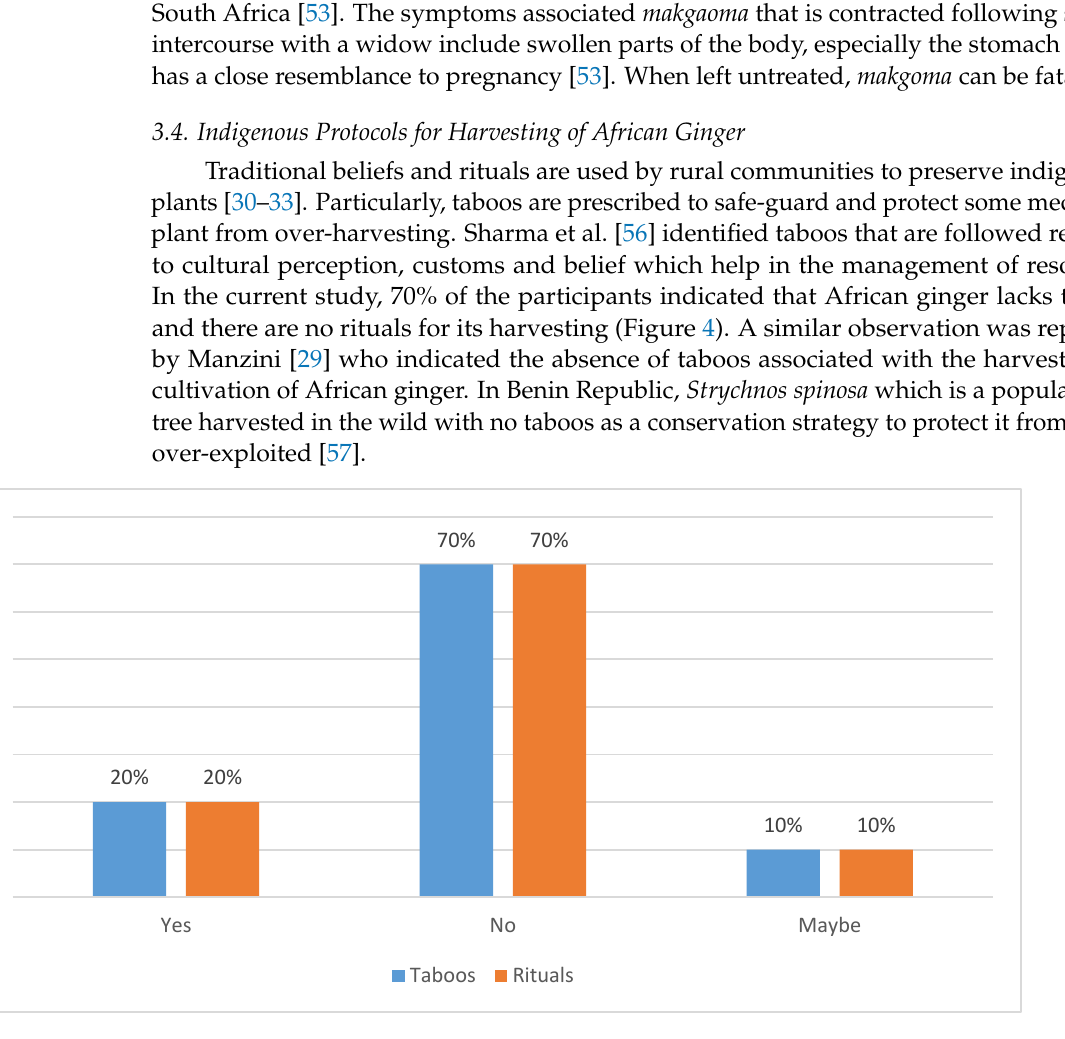
Figure 4. Responses (%) on the importance of rituals and taboos for African ginger harvesting by the participants.